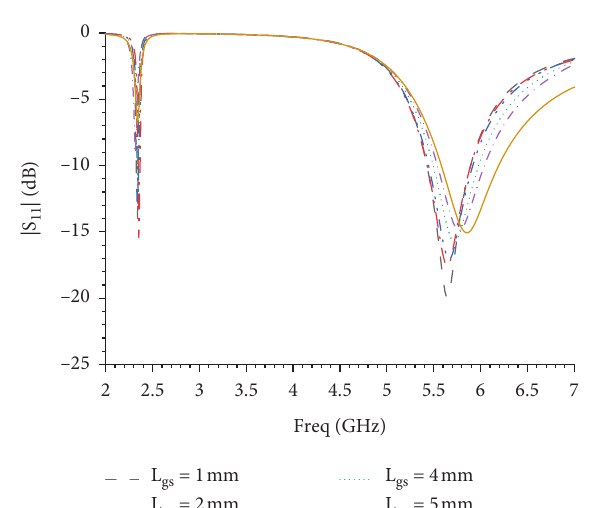
Figure 6: S11 variation due to L